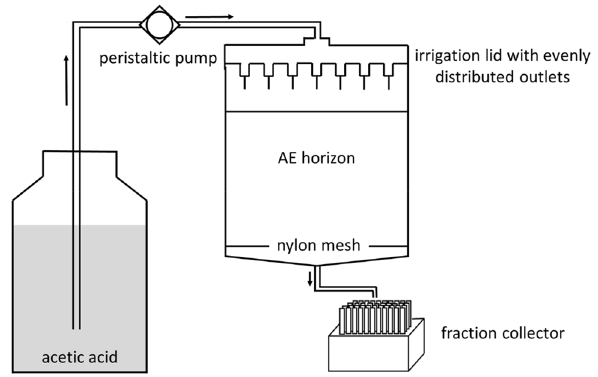
Figure 6. Schematic illustration of the release experimental